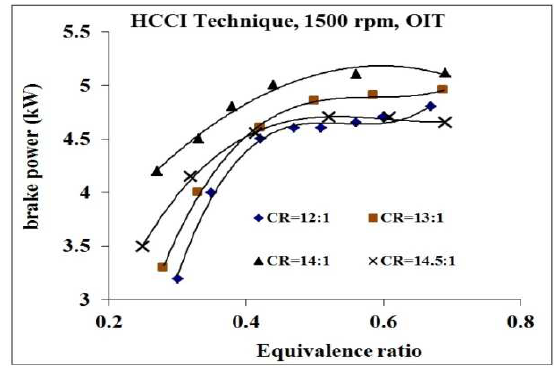
Fig. 3. Compression ratio effect on brake power for wide range of equivalence ratios for HCCI